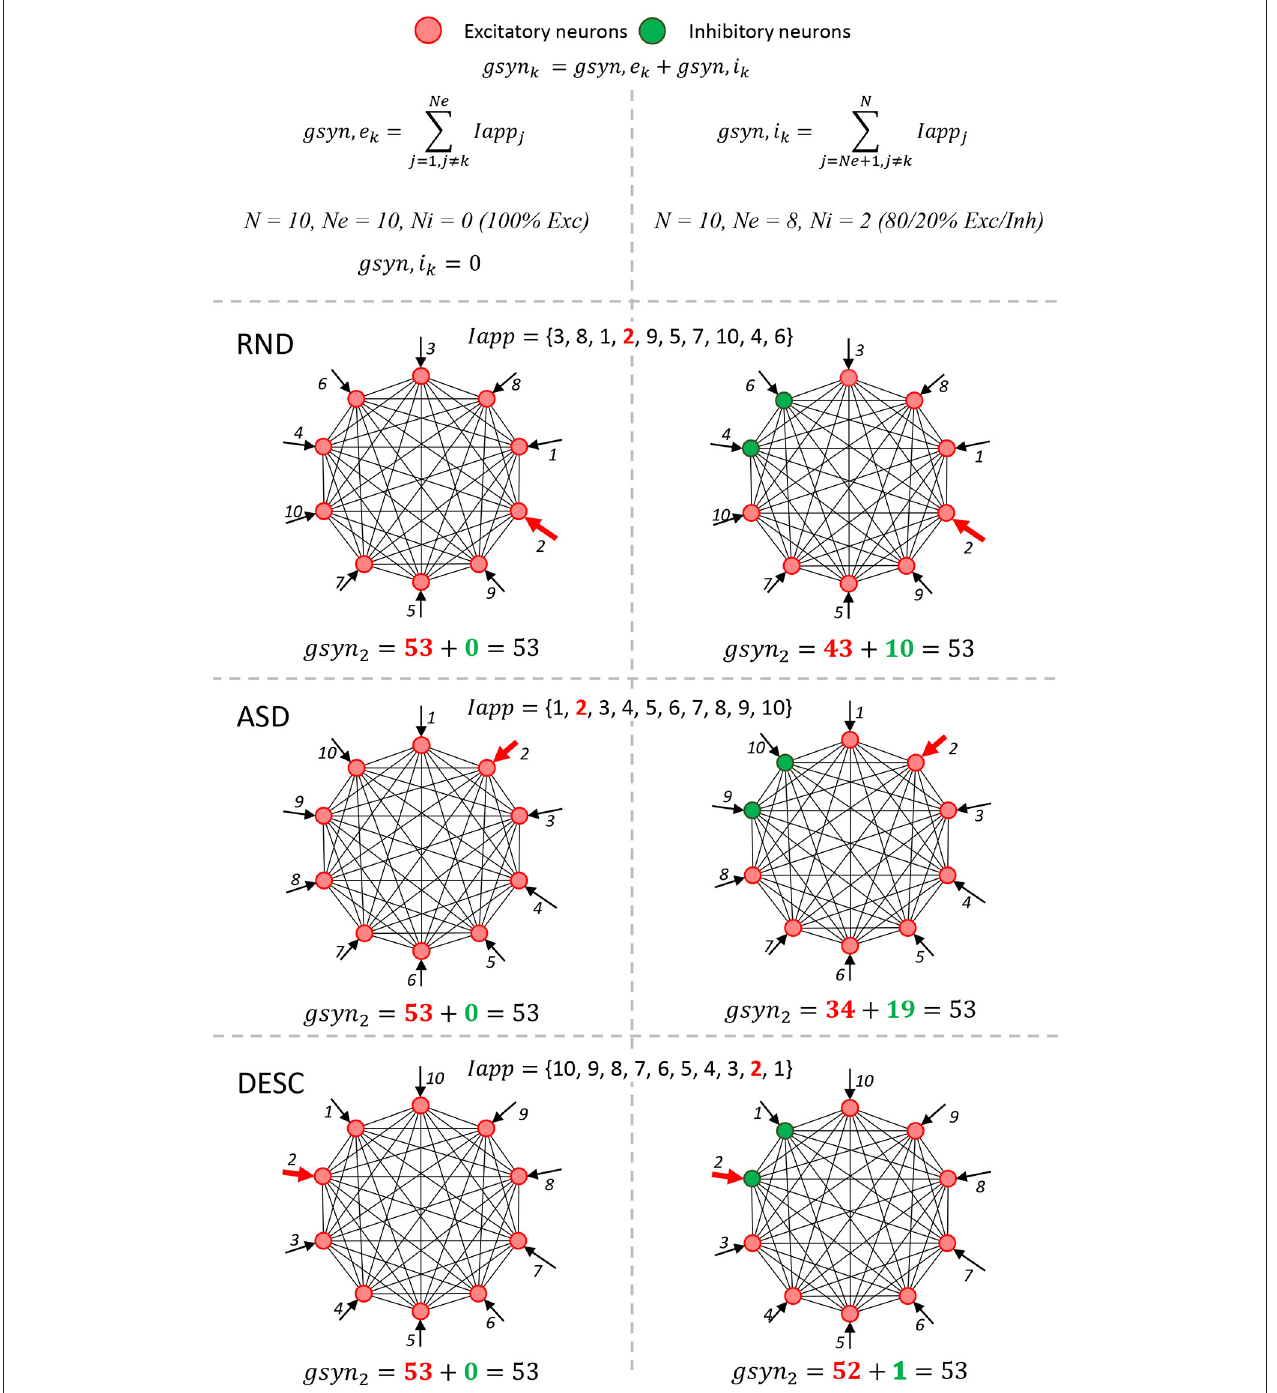
FIGURE 1 | The integration of pre-synaptic activity must obtain the same value. A simple neural network schema composed by 10 neurons shows the six simulation scenarios (3x2, rows and columns) that modify the computational model ( Table 2 , fourth and fifth rows). The columns represent two scenarios involving the proportion of Ne and Ni : 100% excitatory neurons (first column) and 80/20% of excitatory/inhibitory neurons (second column). These scenarios change the associativity in the conductance summation of presynaptic activity values (Equations 10 and 11). For simplification, the formulas and graphs represent the integration of presynaptic activity of one neuron k ( k = 2,g syn 2 ), and the Iapp values were integers (also similar to indices). When 100% of neurons are excitatory, only one summation was = 0); while in the 80/20% case, the total g synk is calculated with two summations, the calculated ( g syn , e ), since there are no inhibitory neurons in the network ( g syn , i k k g syn , e and g syn , i . Rows from the second to the end represent three ways of how the I app vector is ordered: Random (RND), Ascendant (ASD) and Descendent k k (DESC). These scenarios change the commutation in the conductance summation of presynaptic activity values. The total summation formulas for all scenarios are shown at the bottom of each